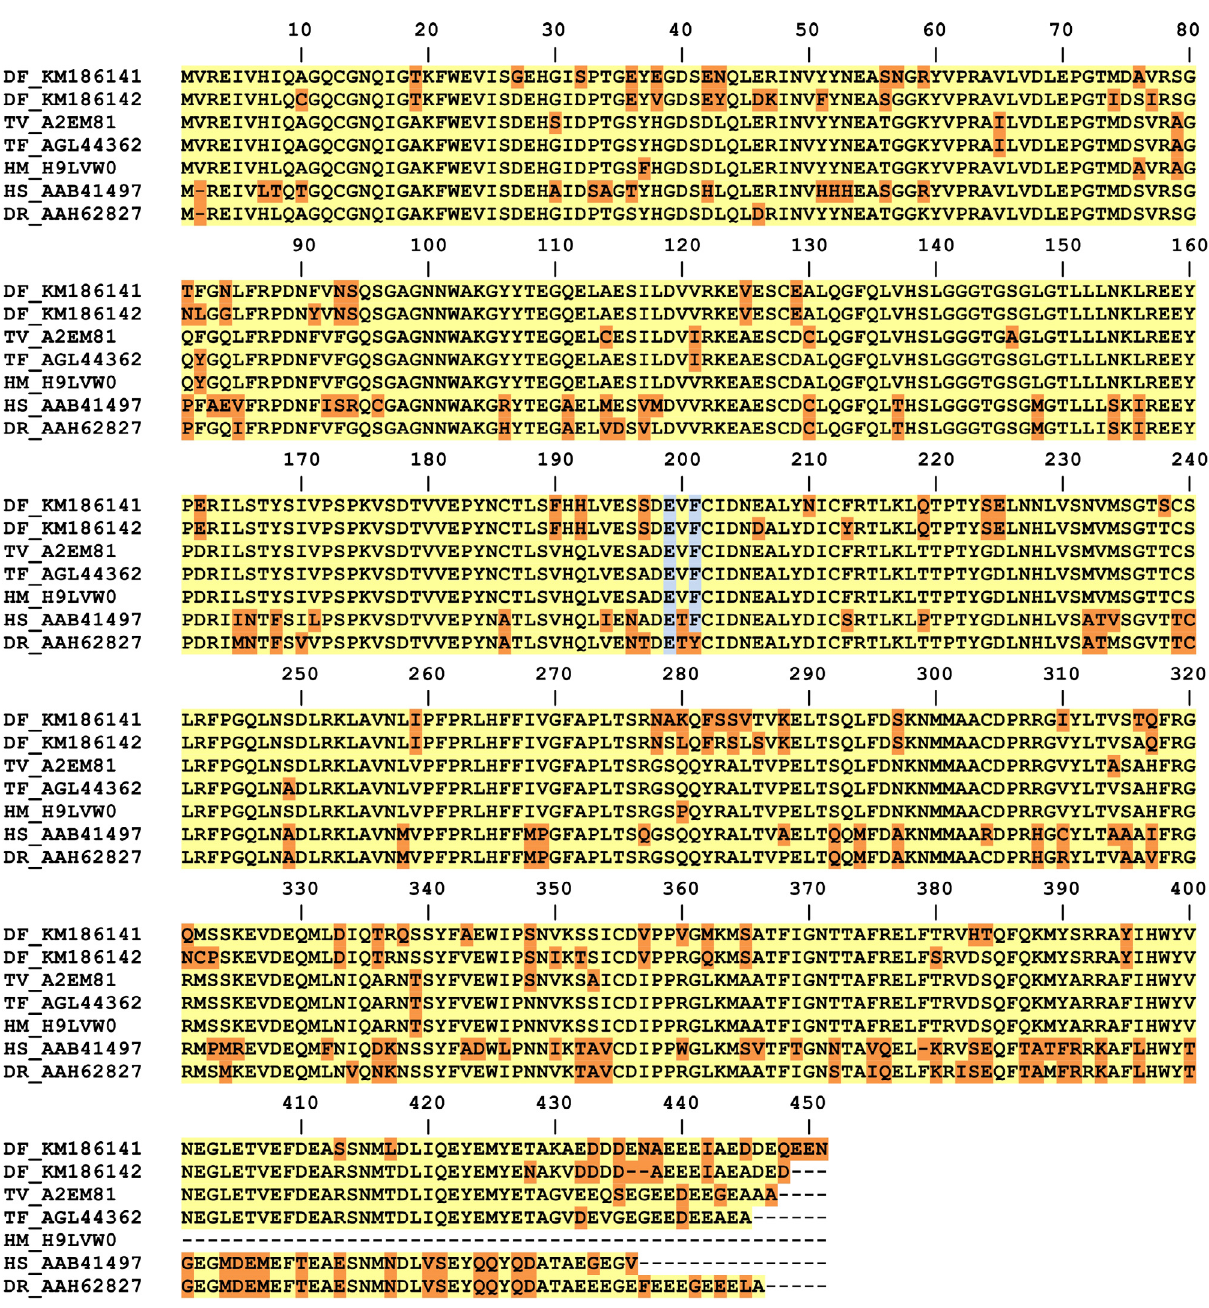
Figure 1. Full alignment of beta-tubulin amino acid sequences from D. fragilis with tubulin sequences derived from Trichomonads and other eukaryotes.Theresidues highlightedblueare thosethoughttobepredictorsofalbendazolesusceptibilityinprotozoaasdescribedinpreviousstudies. Amino acids shaded yellow represent the most common amino acid at that position (predicted consensus based on this alignment). Amino acids shaded orange are those which differ from the predicted consensus. Note however that at positions 8, 430, 434 and 446, a consensus cannot be resolved. TV: Trichomonas vaginalis , DF: Dientamoeba fragilis , HM: Histomonas meleagridis , TF: Tritrichomonas foetus , HS: Homo sapiens , DR: Danio rerio . For Histomonas meleagridis and Trichomonas vaginalis the species acronym is followed by the corresponding UniprotKB identifier. For all other organisms, the species acronym is followed by the corresponding Genbank accession